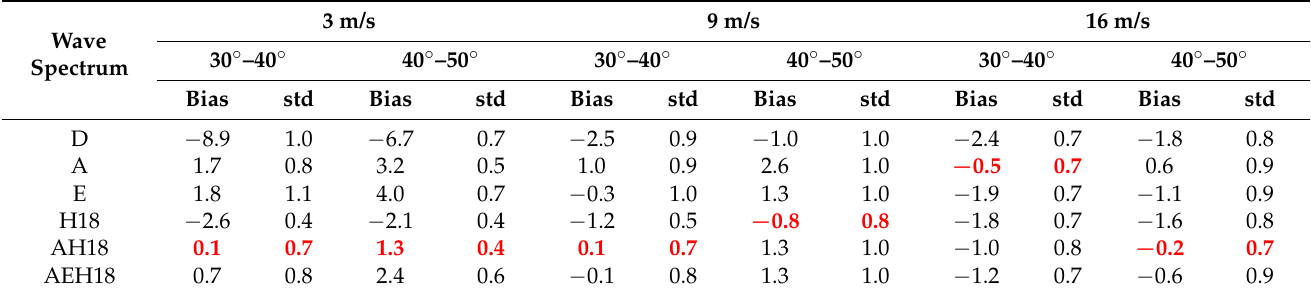
Table 2. The offset (bias) and standard deviation (std) of the simulated NRCS shown in Figure 8 relative to the ASCAT